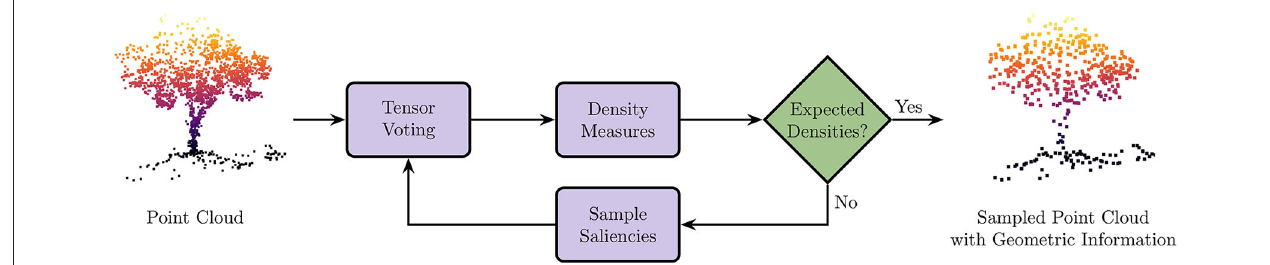
FIGURE 2 | Overview of our sampling strategy. Point cloud is given as input. First, we identify the geometric primitives along with their saliencies using the Tensor Voting framework. Then, we derive density measures from saliencies: if the density for each geometric primitive is less than the desired density, we stop; else we sub-sample each geometric primitive, and re-iterate. As output, we have a uniform sampled point cloud enhanced with geometric